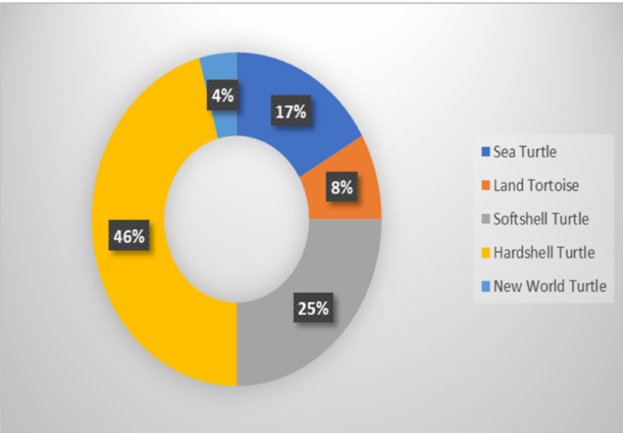
Figure 1. The diversity of turtles in